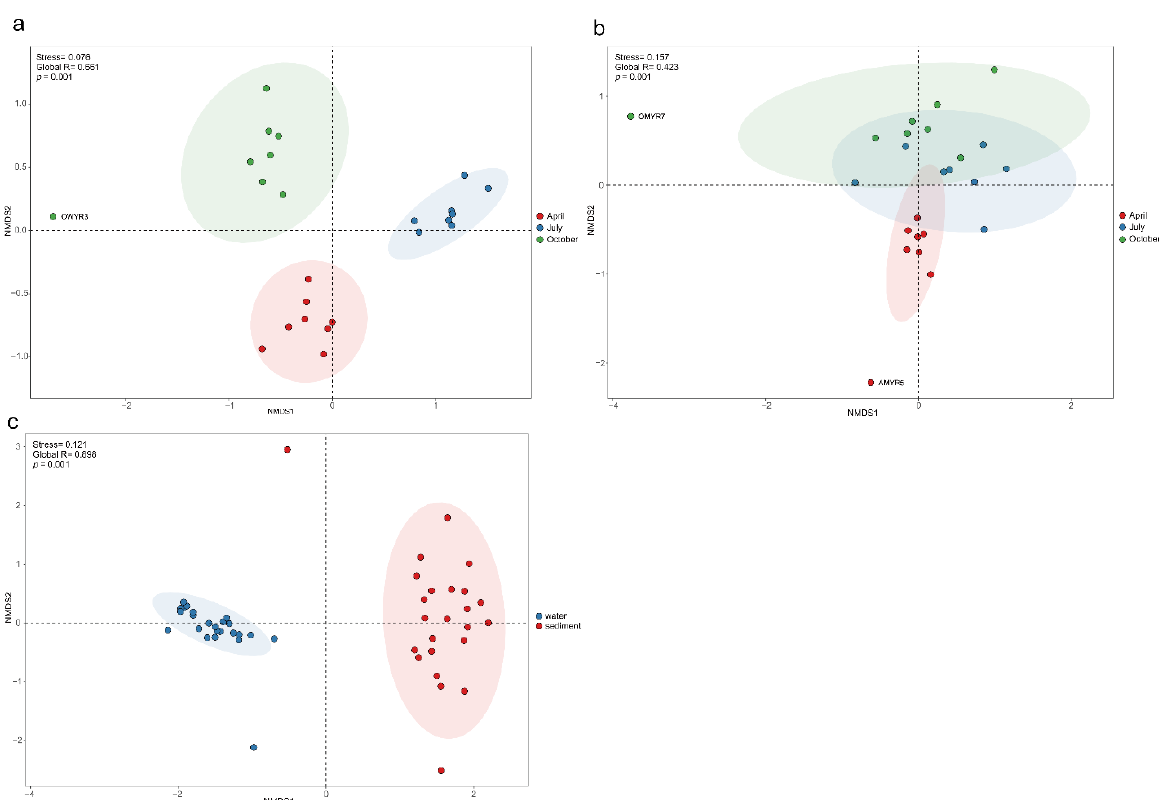
Table 1. Water environment parameters (mean ± SD) of the Taiyangshan wetland in different sampling periods.